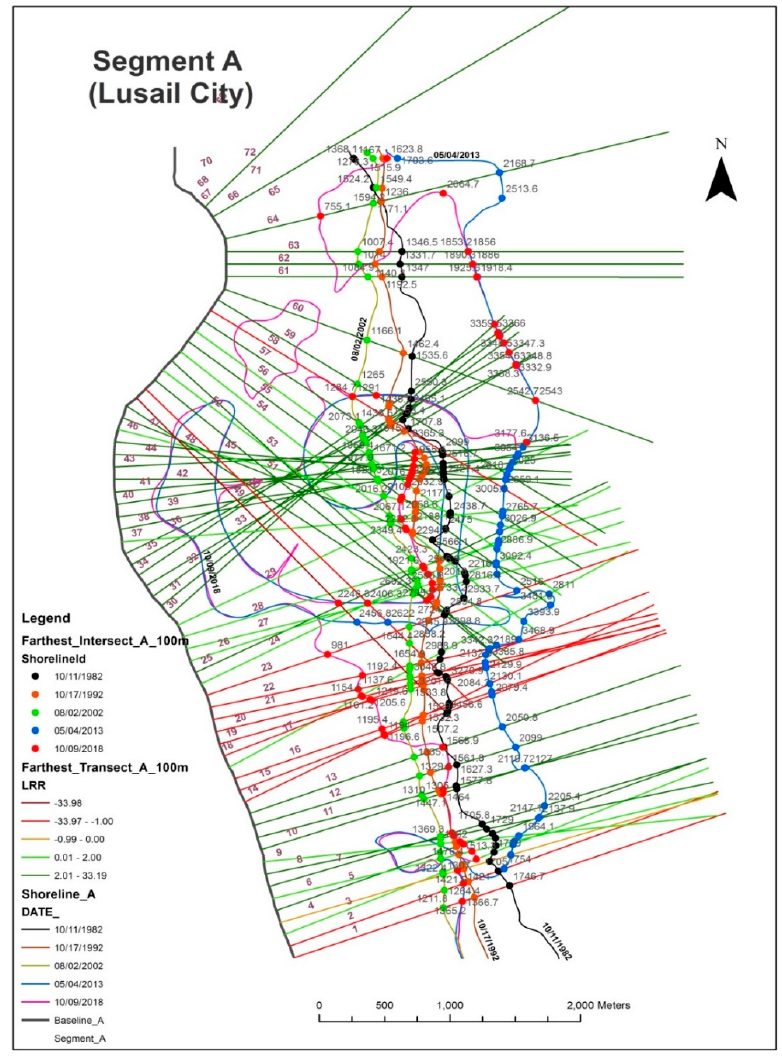
Figure 6. Shoreline map of Segment A.